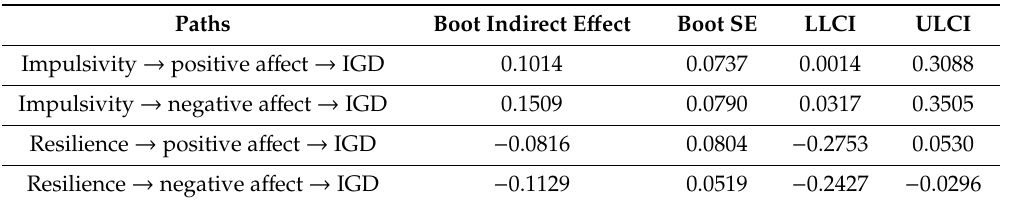
Table 3. Model of mediation analysis of a ff ect status between impulsivity or resilience and severity of IGD symptoms in the IGD group.